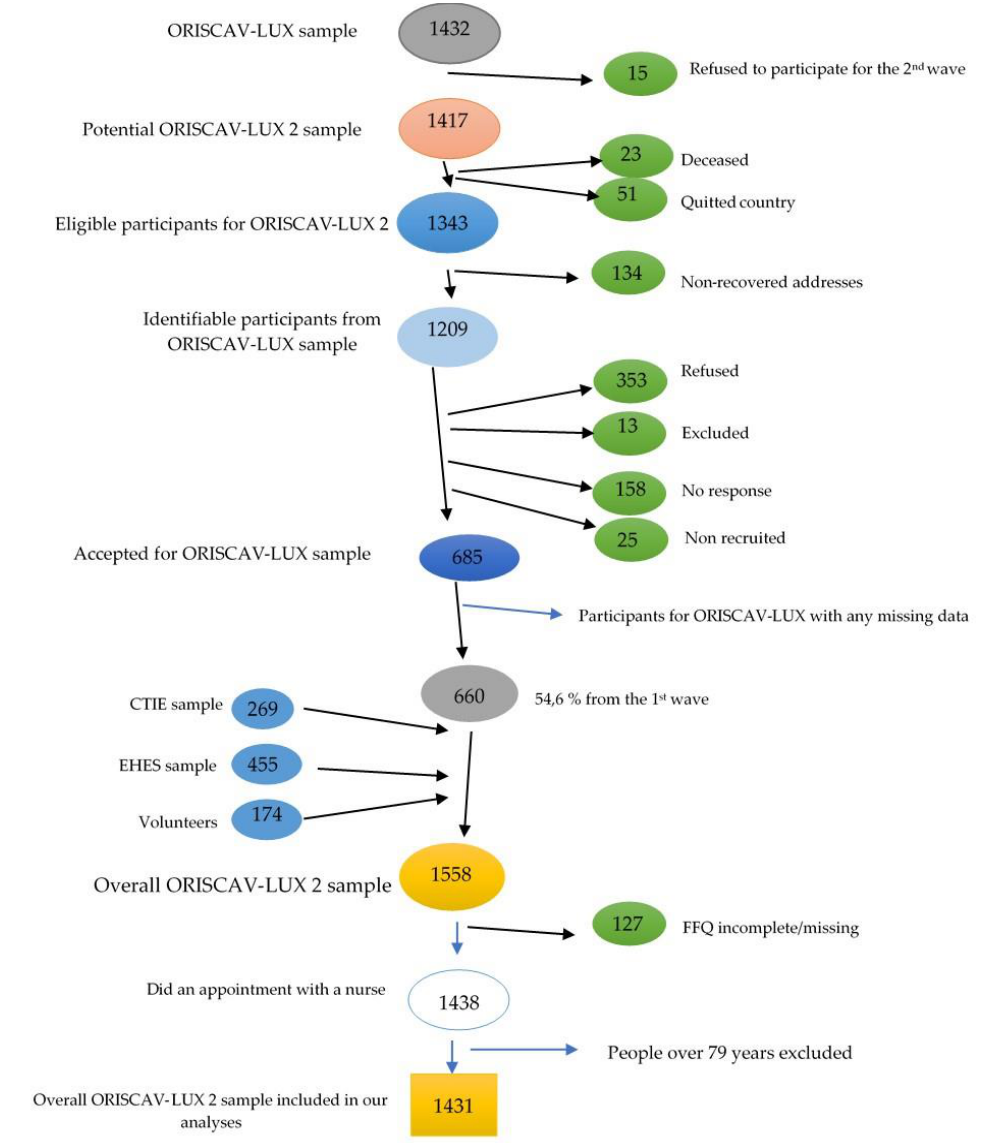
Figure 1. Participant sample progression. Fifteen people refused to participate in the second wave from the outset, lowering the number of potential participants to 1417. When sending the invitations of participation for the second wave, 134 addresses were not found, further decreasing the total number to 1209. Of these identified people, 353 refused to participate, 13 were excluded (moved abroad, physical disability or language incapacity), 25 (non-recruited) did not attend or canceled their repeated appointments, and 158 did not respond to the invitation; thus, 685 people from the first sample accepted participation in the second wave. CITIE = Centre des technologies de l’information de l’Etat, EHES = European Health Examination Survey. FFQ = food frequency